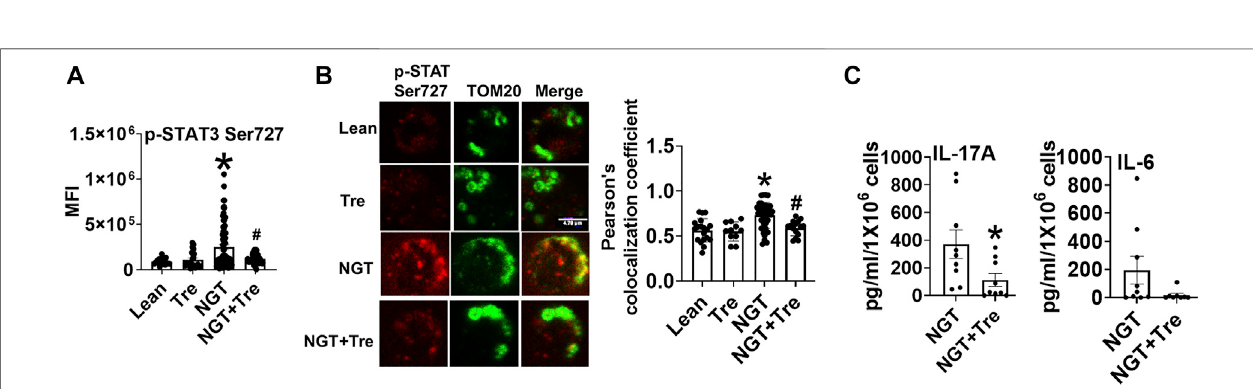
FIGURE3| Nutraceutical trehaloseblocks p-Ser 727- STAT3 – mitochondrial translocation and lowersin fl ammationin NGT. (A) p-Ser-727 STAT3 expression; (B) mitochondriallocalization(leftpanel , representativeimages,andrightpanelquanti fi cation);and (C) cytokineproductionasmeasuredbybio-plexassaybycellsfromNGT subjectsaftertrehalosetreatment.N=4 – 7, (A,B) andN=7 – 9, (C) .EachNrepresents cellsobtained fromonesubject.Atleast7 – 10 fi eldsperslidewereimagedat63× magni fi cation with oil immersion, on a Zeiss LSM 800 confocal microscope. In fi elds where numerous cells/ fi elds were observed, the averages are plotted. The brightness of the images was enhanced to improve clarity. * p < 0.05 vs lean or NGT, # p < 0.05 vs NGT.